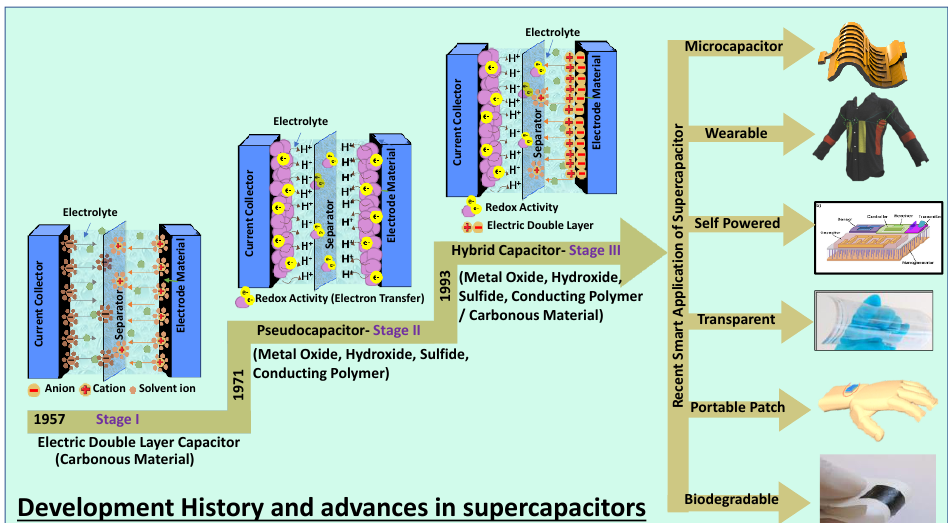
Figure 1. Classification of supercapacitors based on various electrode materials and their advanced applications.